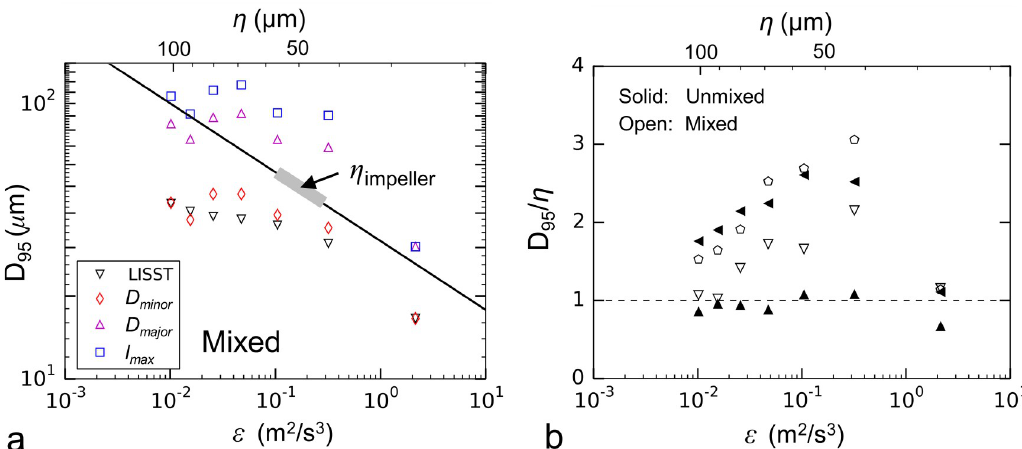
Fig 15. Effects of particle lengthscale on the breakup trends. (a) Floc strength curves plotted with lengthscales obtained from the LISST and from the image analysis for a mixed aggregation tank condition. Kolmogorov lengthscale of the siphon flow plotted as the solid black line. (b) D of the Feret-diameter particle spectra normalized with the Kolmogorov lengthscale of the 95 siphon flow and plotted against the dissipation rate in the siphon tubes. Symbols in (b) consistent with Table